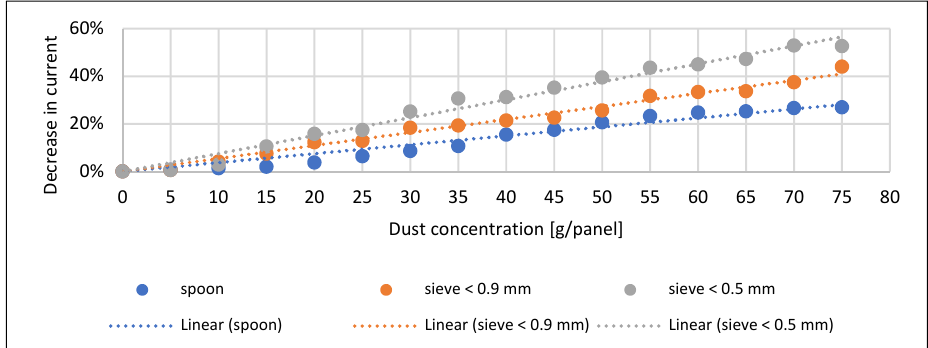
6 of 13 Figure 4. The open ‐ circuit voltage values as a function of the soil concentration. The decrease in current is affected by the degree of illumination. The more significant shading effect of the sprinkled contaminant, which spreads better on the surface of the solar panel, resulted in a significant reduction. Figure 5 shows the current ‐ reducing effect